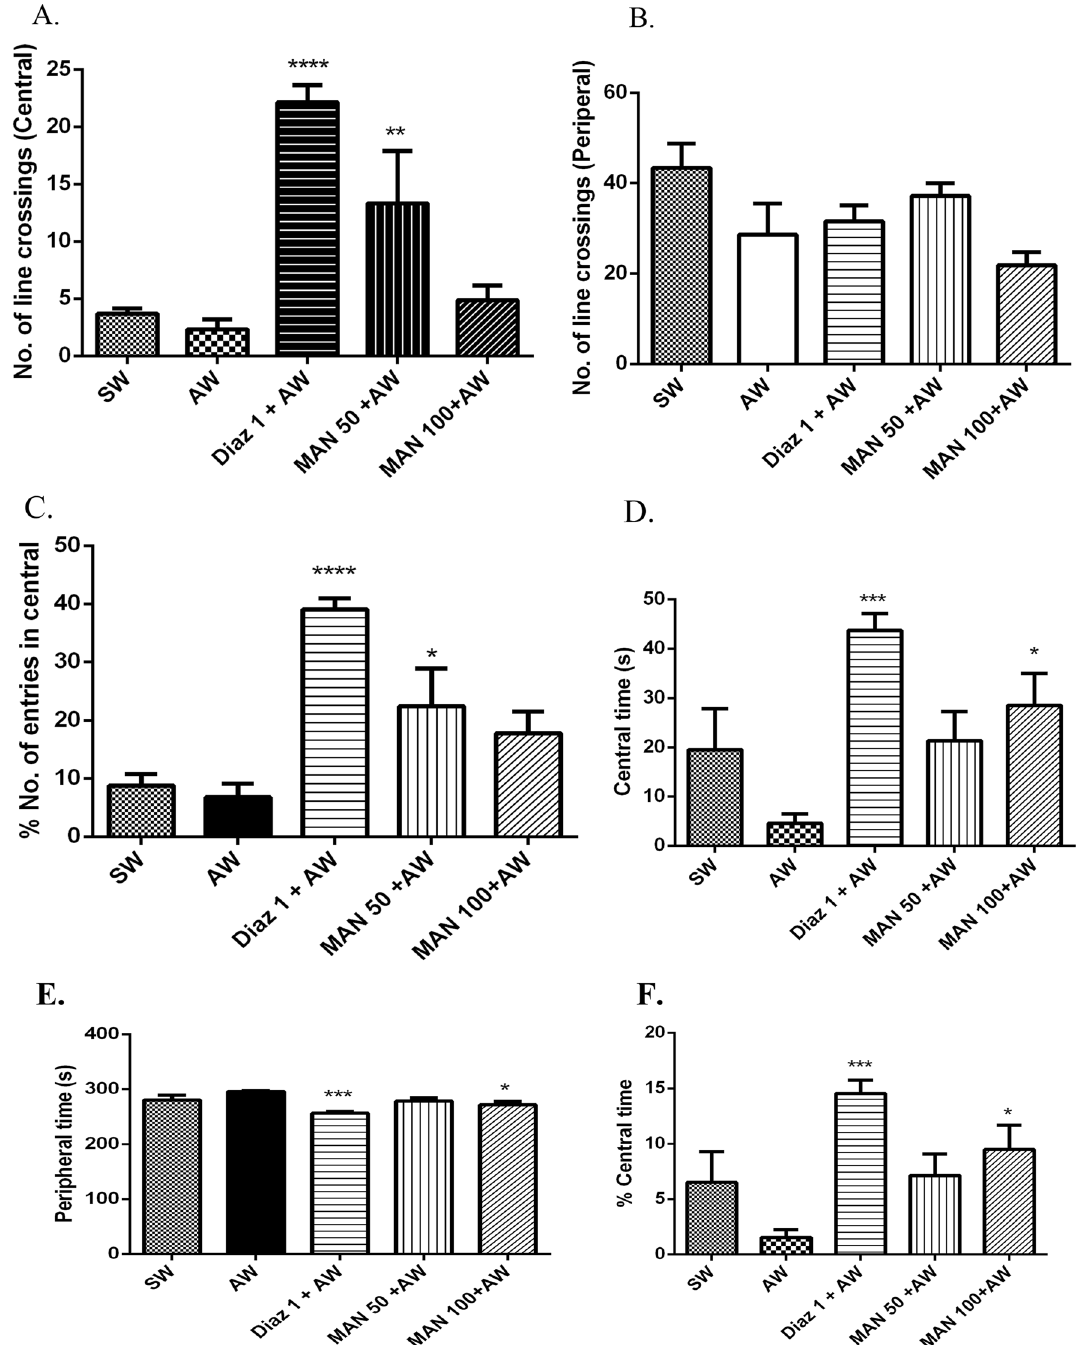
Fig. 2 Effect of MAN (50 and 100 mg/kg p.o.) on A % no. of line crossings in central, B % no. of line crossings in peripheral, C % no. of entries in central, D Central time, E Peripheral time, F % central time in the OFT mouse model. The data were expressed as